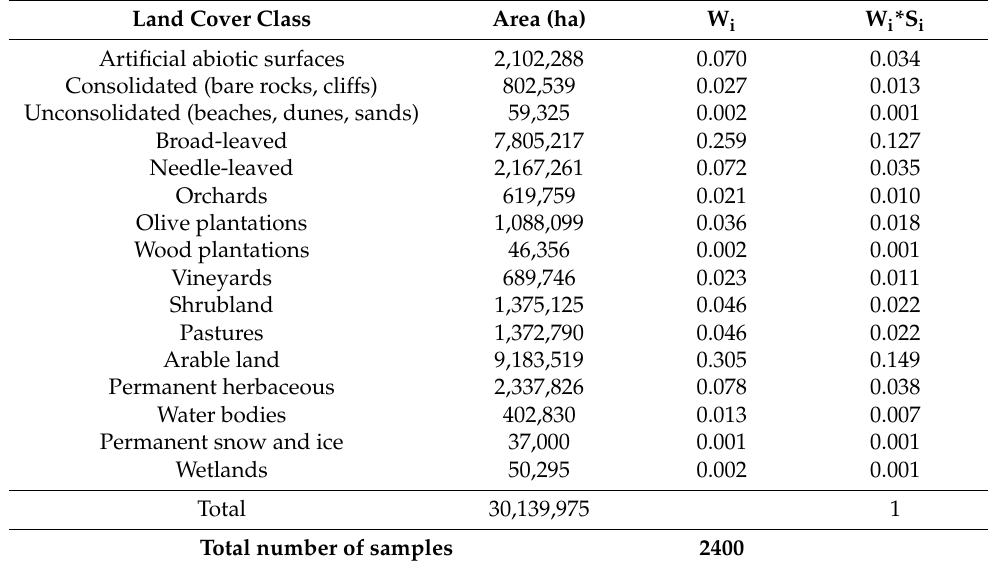
Table 6. Calculation of sample